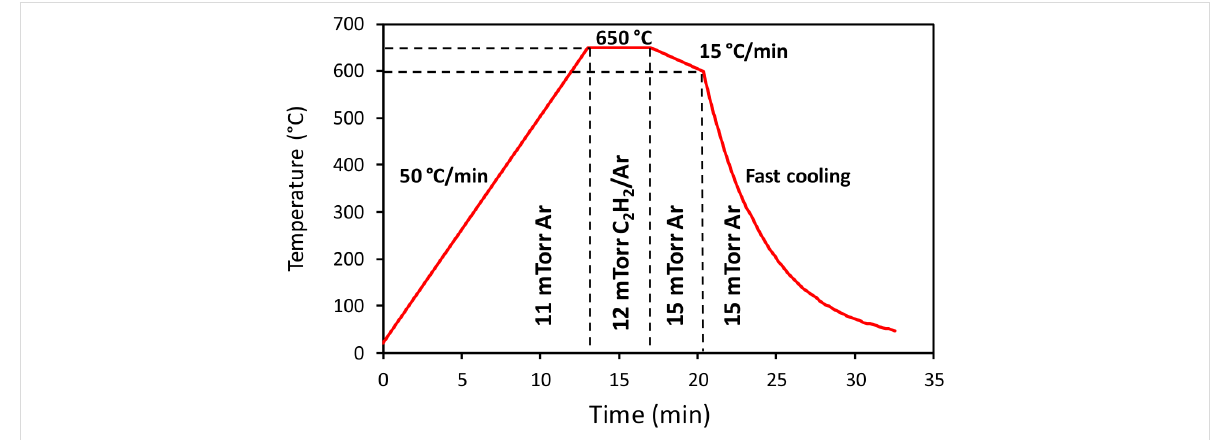
All the films involved in the SMR structure were deposited by sputtering, except the Ir bottom electrode and the Ni catalyst that were e-beam evaporated. The deposition conditions of the AlN and SiO 2 layers in the reflector were carefully adjusted to minimize residual stresses in each film. The final devices were capable of sustaining temperatures as high as 1000 °C for at least two hours, without significant degradation of their perfor- mance [27]. Although the devices could withstand such extreme conditions, the growth of graphene was carried out at lower temperatures to prevent the devices from degradation, no matter how